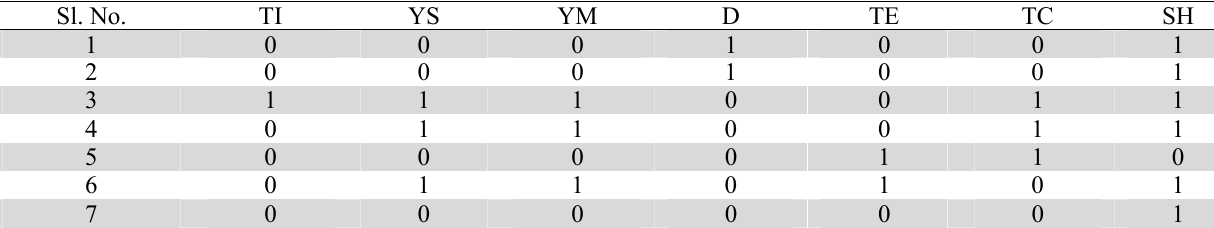
Incidence matrix ( B 8 ) at slicing parameter θ 8 = 0.80 for example 2 Sl. No.